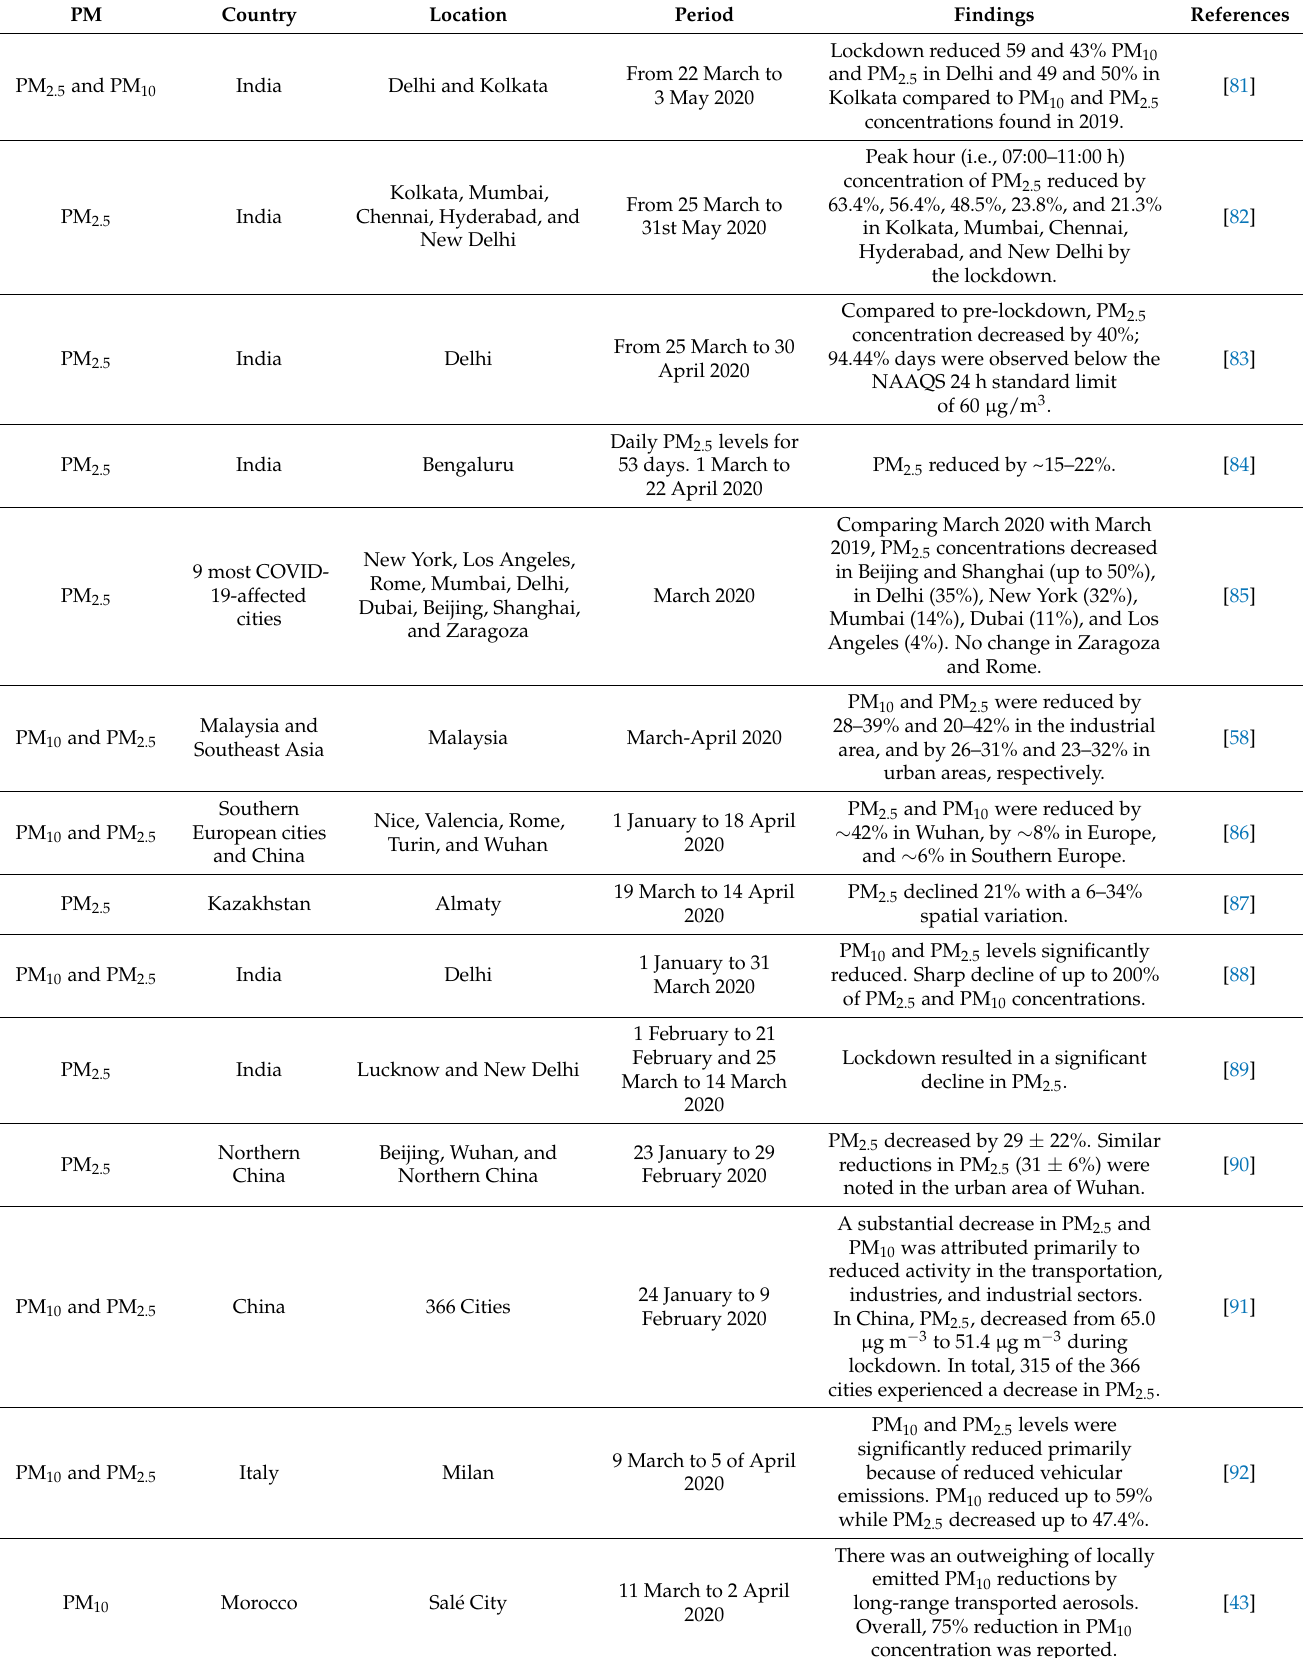
Table 1. Impact of lockdown on PM